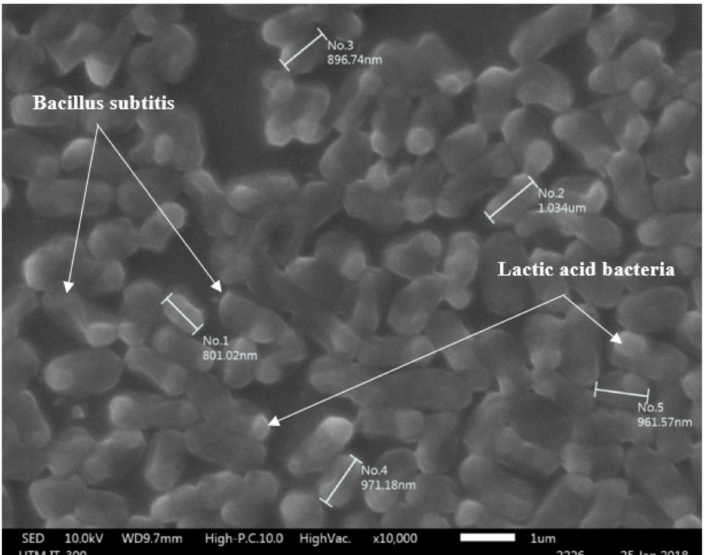
Figure 1. SEM image of the Bacillus subtilis and lactic acid bacteria in EM